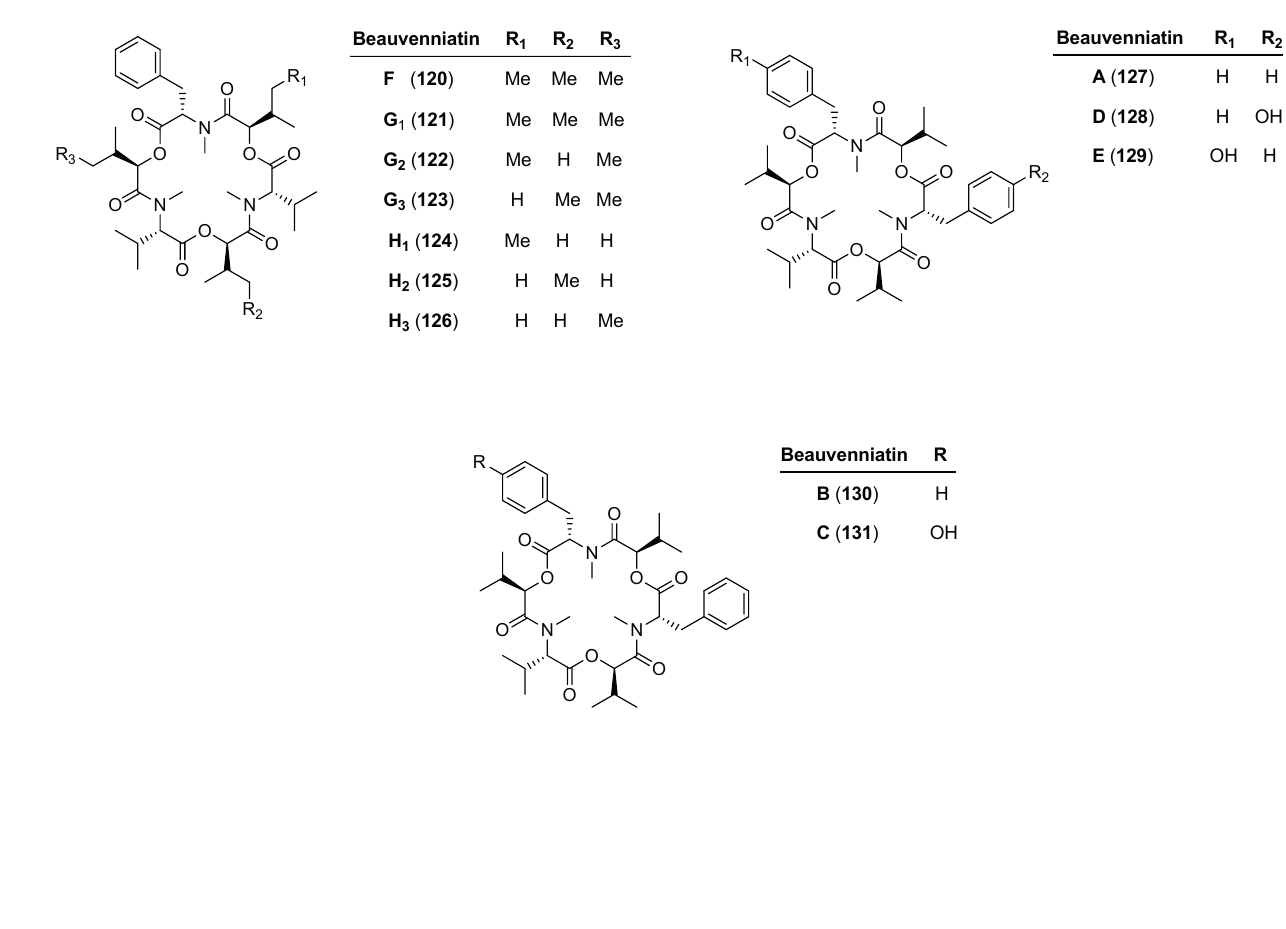
Figure 11. Structures of beauvenniatins 120 – 131